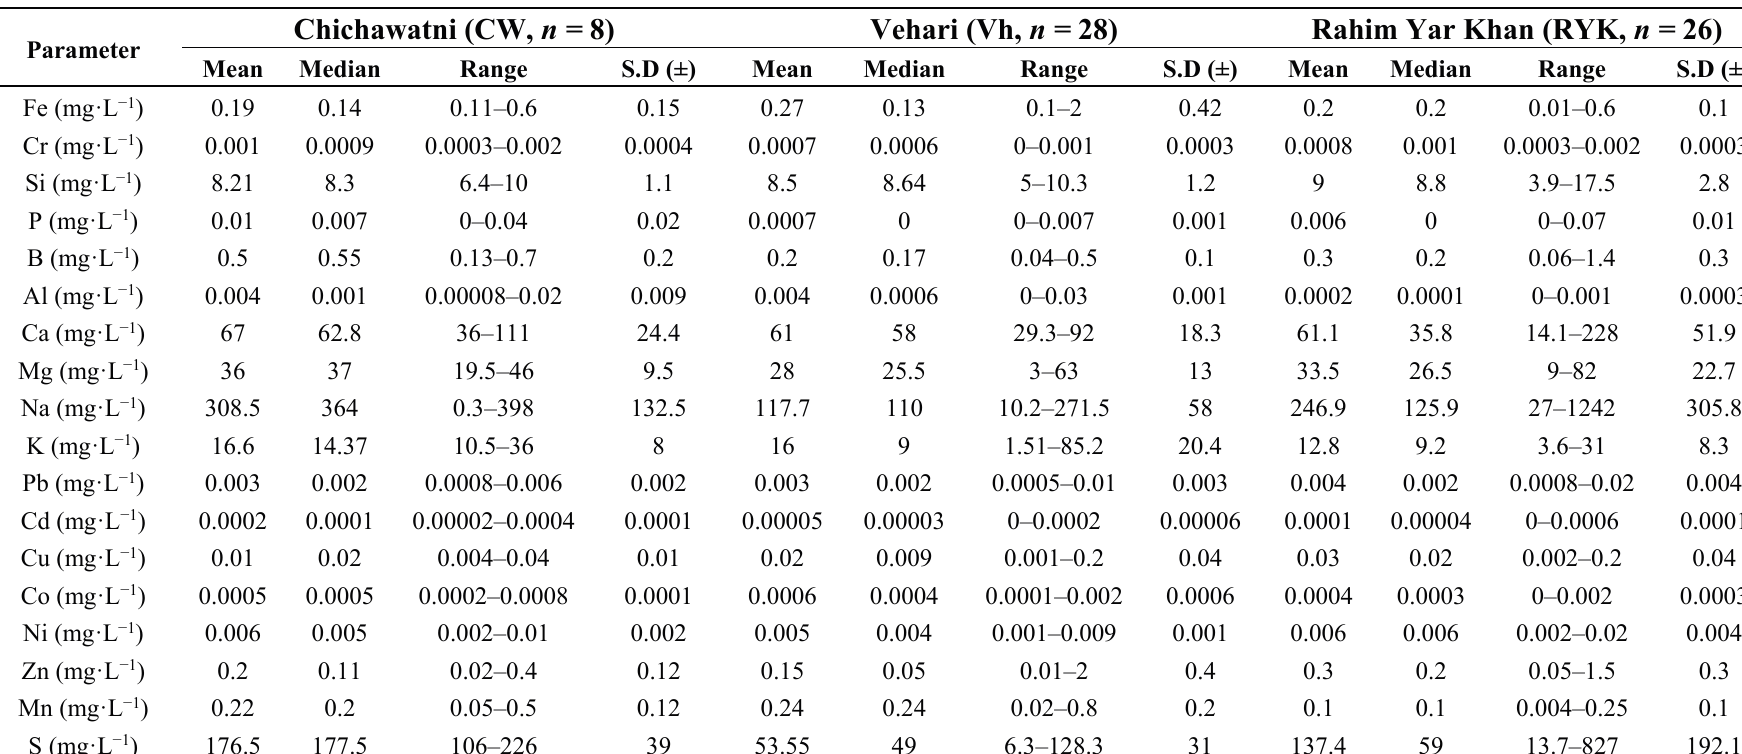
Table 3. Summary statistics of major cations and trace metals in groundwater samples collected from three rural areas of Punjab, Pakistan.